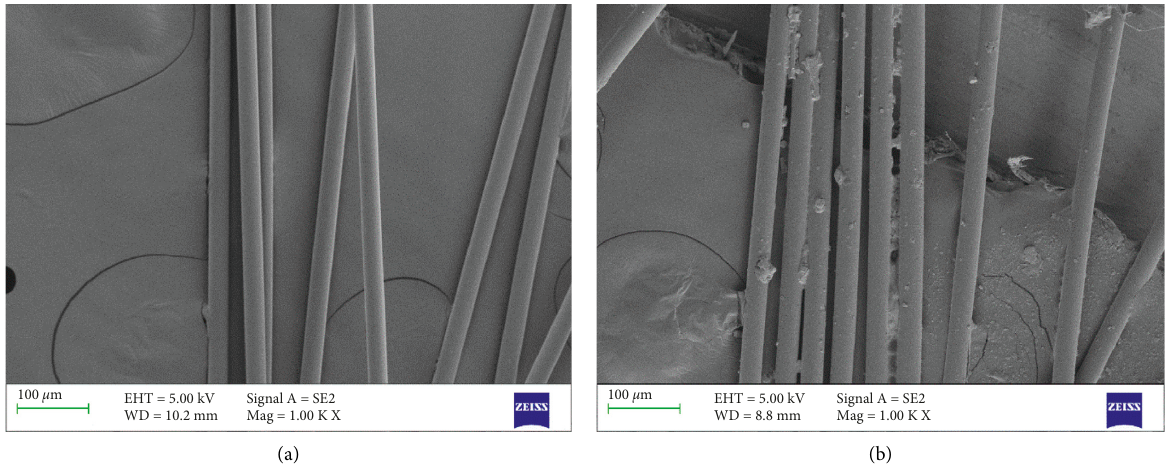
Figure 9: (a) SEM for raw PP fiber. (b) SEM for SPS-dipped PP